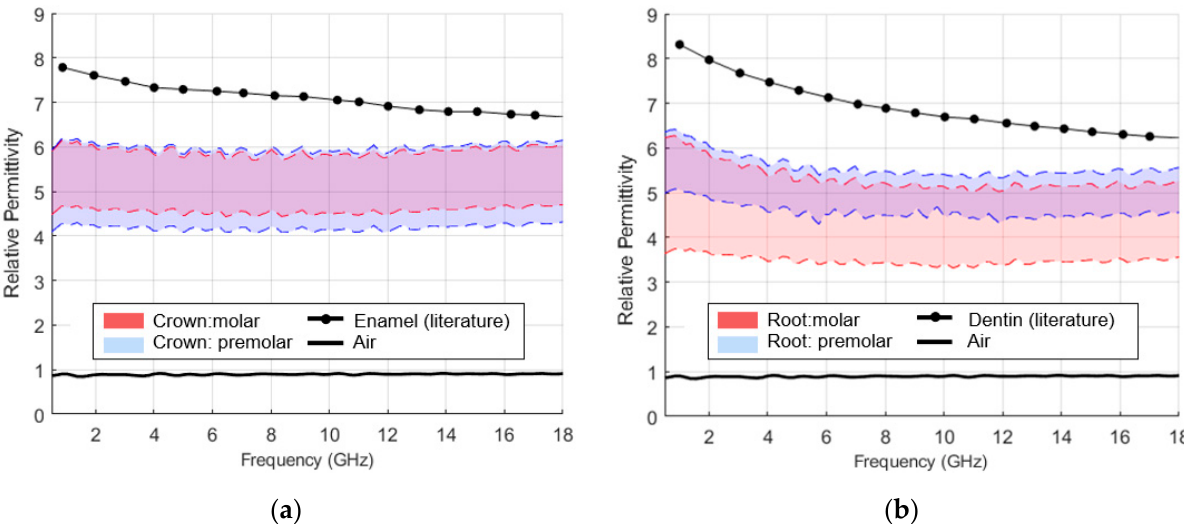
Figure 9. Relative permittivity recorded throughout the repeatability study: ( a ) on the dental crown; ( b ) on the dental root. The measurements performed on the molar and premolar are represented by red and blue shaded bands, respectively. The upper and lower limit of the recorded relative permittivity range, for each of the measurement positions, is shown by dashed lines. The dielectric properties of air, dentin and enamel, available in the literature [37], are presented for reference. For the considered frequency range, the recorded relative permittivity average percentage variation ranged from 18.1% to 34.5%, for the considered measurement sites.